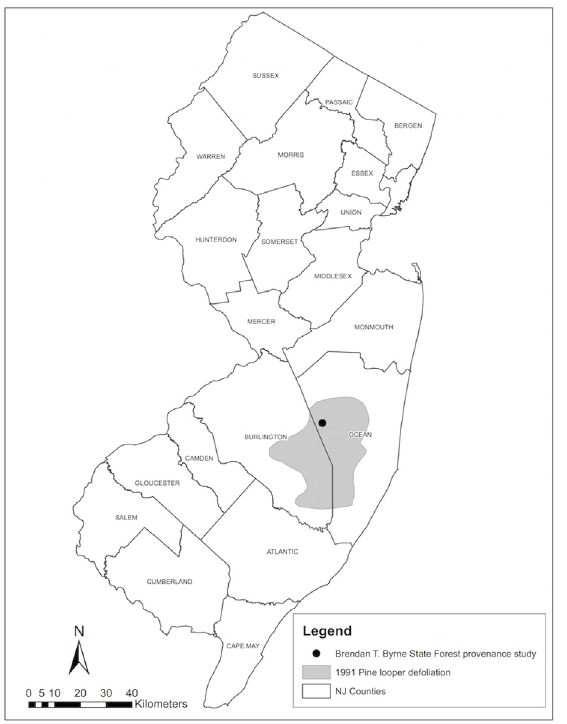
Fig 7. New Jersey defoliation damage in October-November 1991. The gray represents the extent of pine looper defoliation damage. The black dot is the location of the Brendan T. Byrne State Forest.